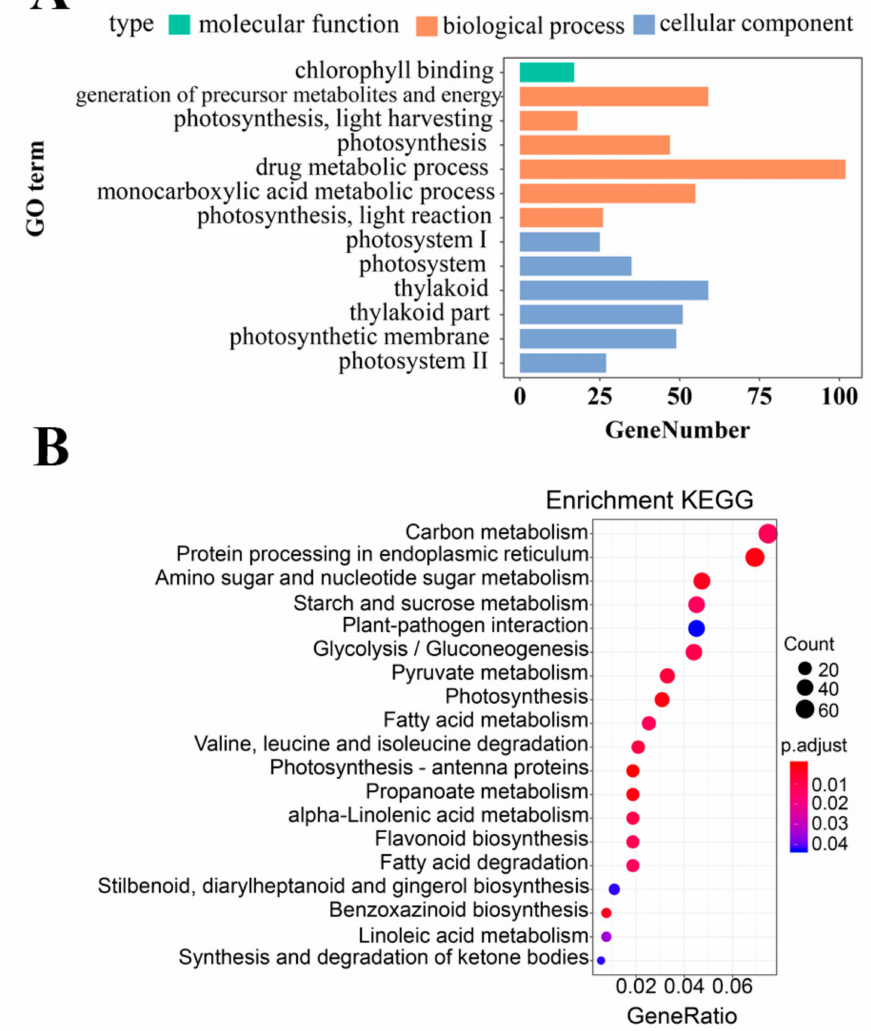
Figure 4. ( A ) Gene ontology (GO) and ( B ) Kyoto Encyclopedia of Genes and Genomes (KEGG) enrichment analysis of di ff erentially expressed